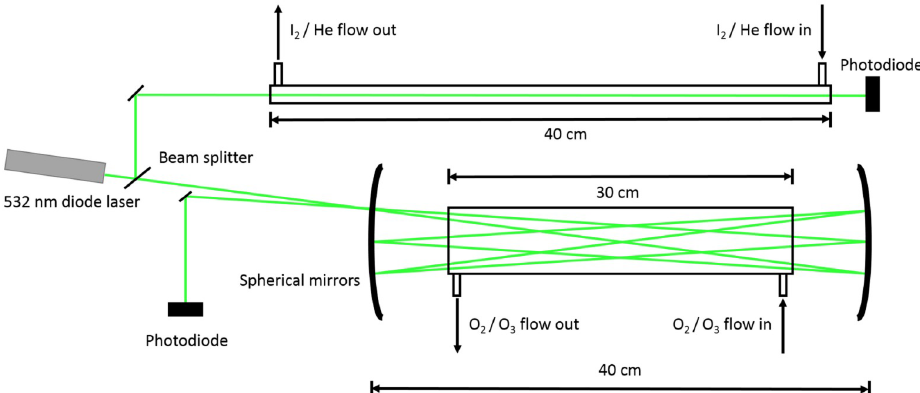
Figure 2. A schematic of the absorption set-up used to measure both I 2 and O 3 .